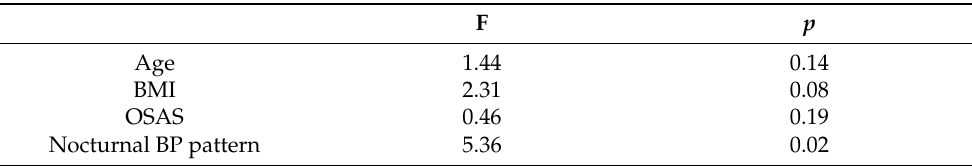
Table 3. Multivariate linear regression model including factors affecting systolic BPV changes: age, gender, BMI, OSAS, and nocturnal BP